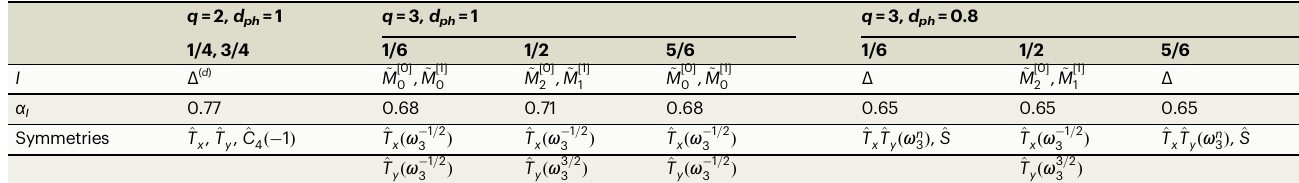
~ M ½ ‘ (cid:4) ~ ρ ½ ‘ (cid:4) k , and k , (SC, SDW, and CDW, respectively) found in the RGanalysis for